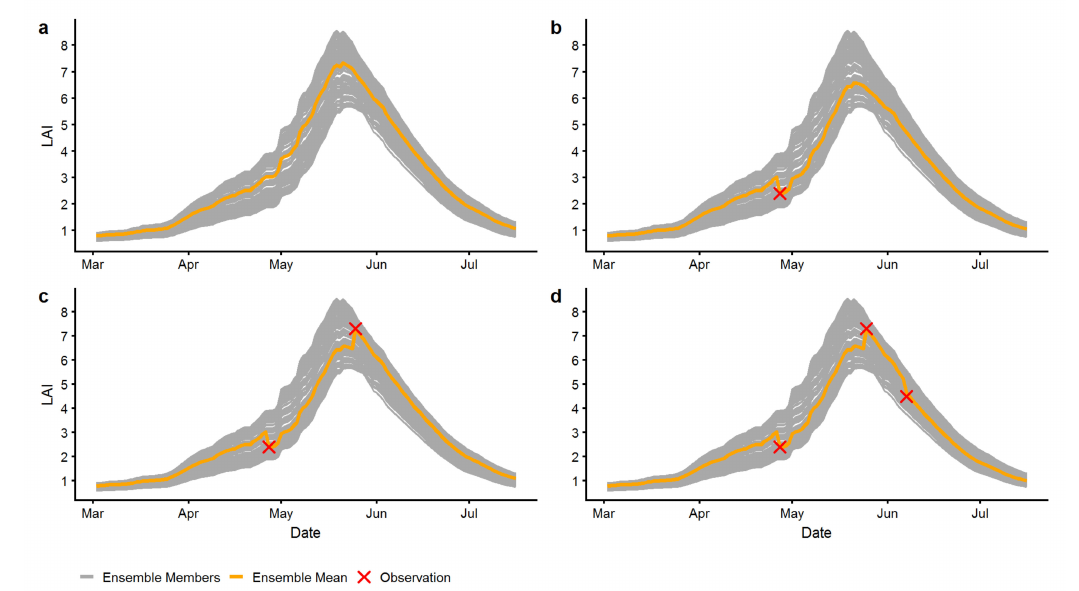
Figure 1. Example of Weighted Mean (WM) approach demonstrating the new ‘virtual data assimilation’ methodology. ( a ) An ensemble is created (orange line shows calculated mean of all ensemble members), ( b ) First LAI observation becomes available (red cross) and the contribution of each ensemble member to the ensemble mean is re-calculated, based on weights that depend on the proximity of the simulated value of the state variable to the observation (Equations (2) and (3)). The weights are propagated until ( c ) the next LAI observation becomes available, and a re-calculation of weights is triggered. ( d ) A third observation becomes available. No model ensemble member status variable is updated at any point in